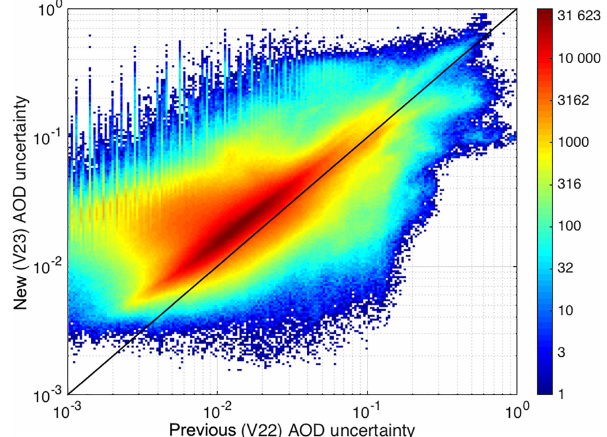
Figure 7. Density plot showing comparison between the previous (V22) AOD uncertainty and the new (V23) AOD uncertainty. The black line is the one-to-one